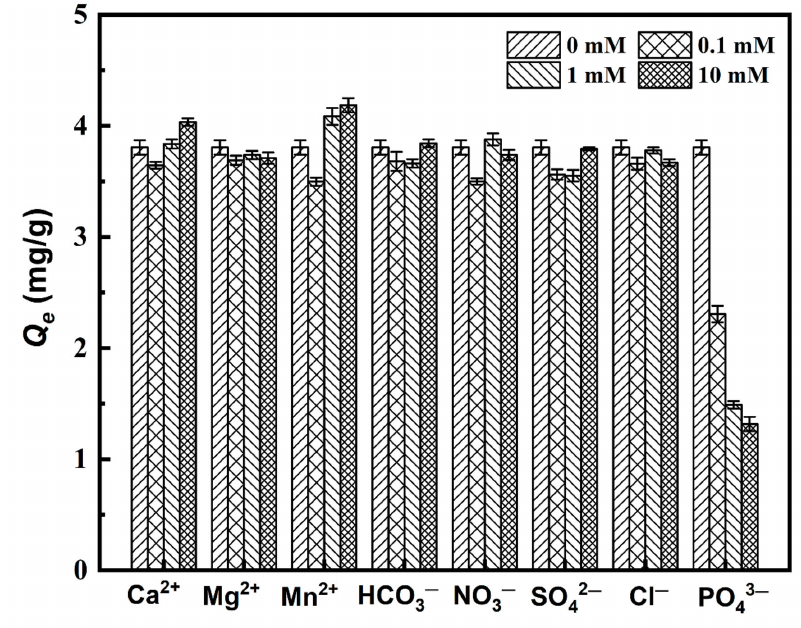
Figure 12. Effects of coexisting ions on the equilibrium adsorption capacity ( Q e ) of